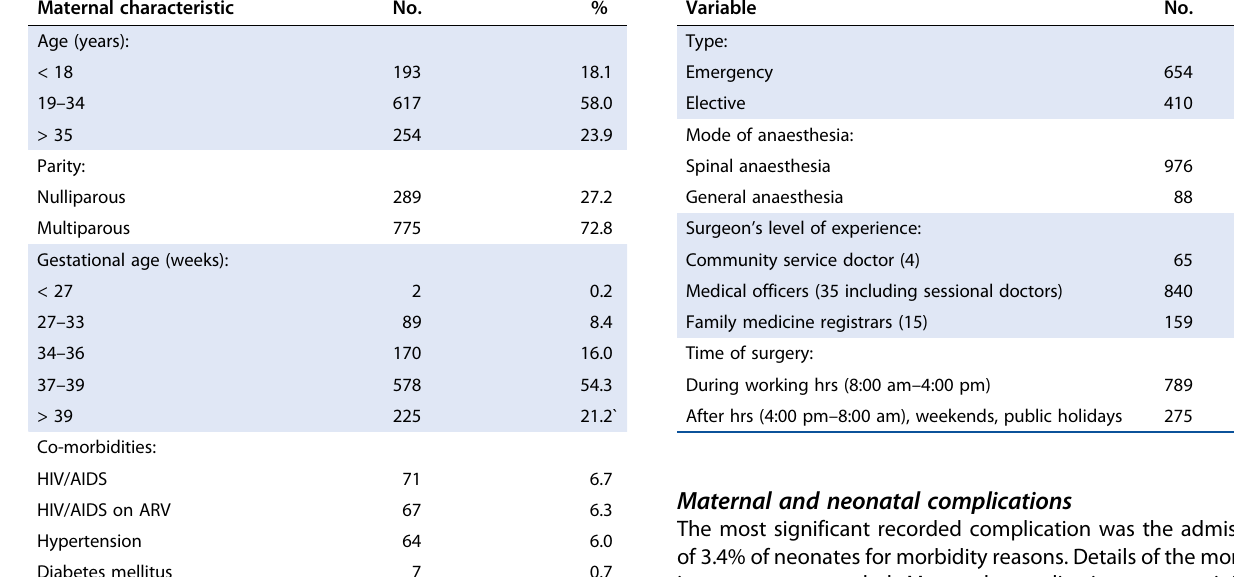
Table 1: Maternal characteristics Maternal characteristic